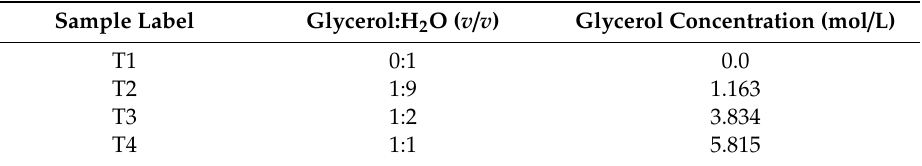
Table 1. Concentration of aqueous glycerol expressed as glycerol:water volume ratio and molarity for the synthesis of colored TiO 2